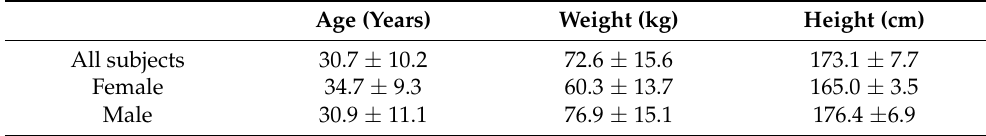
Table 1. Characteristics of the